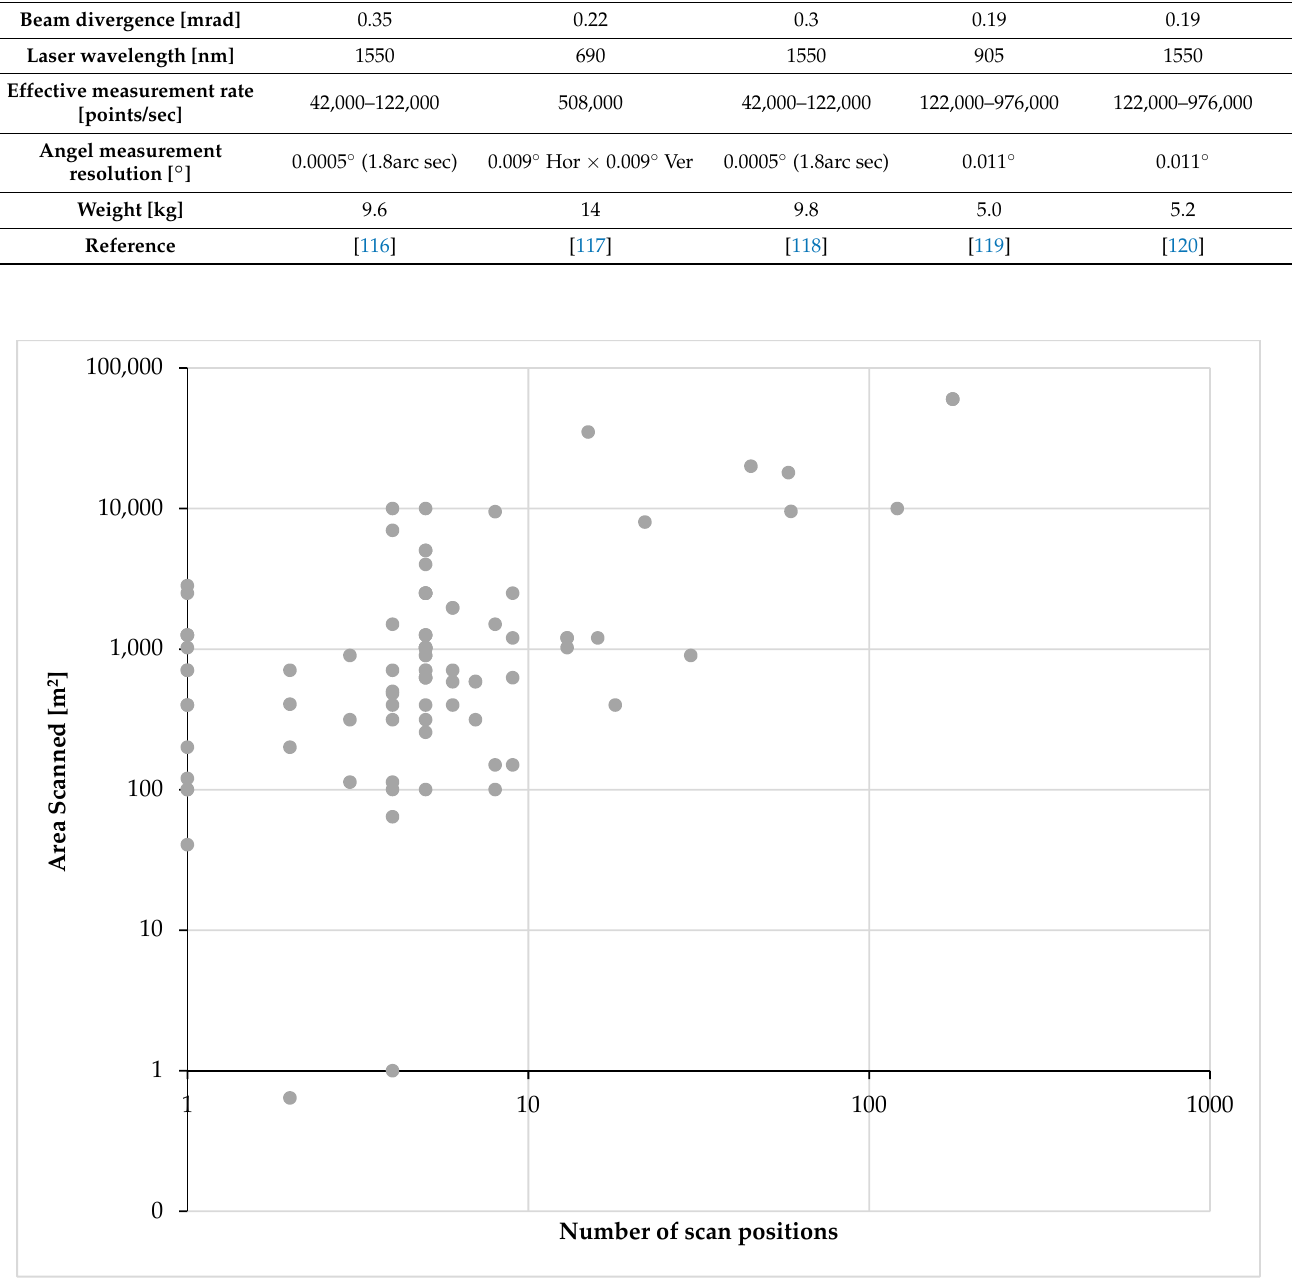
Figure 5. Number of scan positions and area covered (m 2 ) in the reviewed studies.